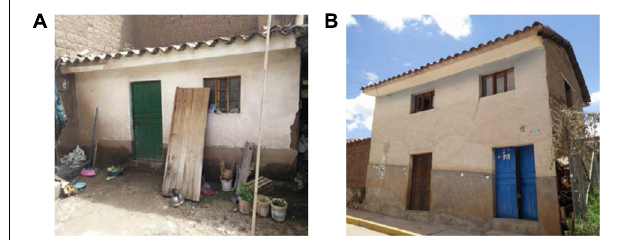
FIGURE 1 | Typical surveyed buildings. (A) One- and (B) two-story adobe dwellings.